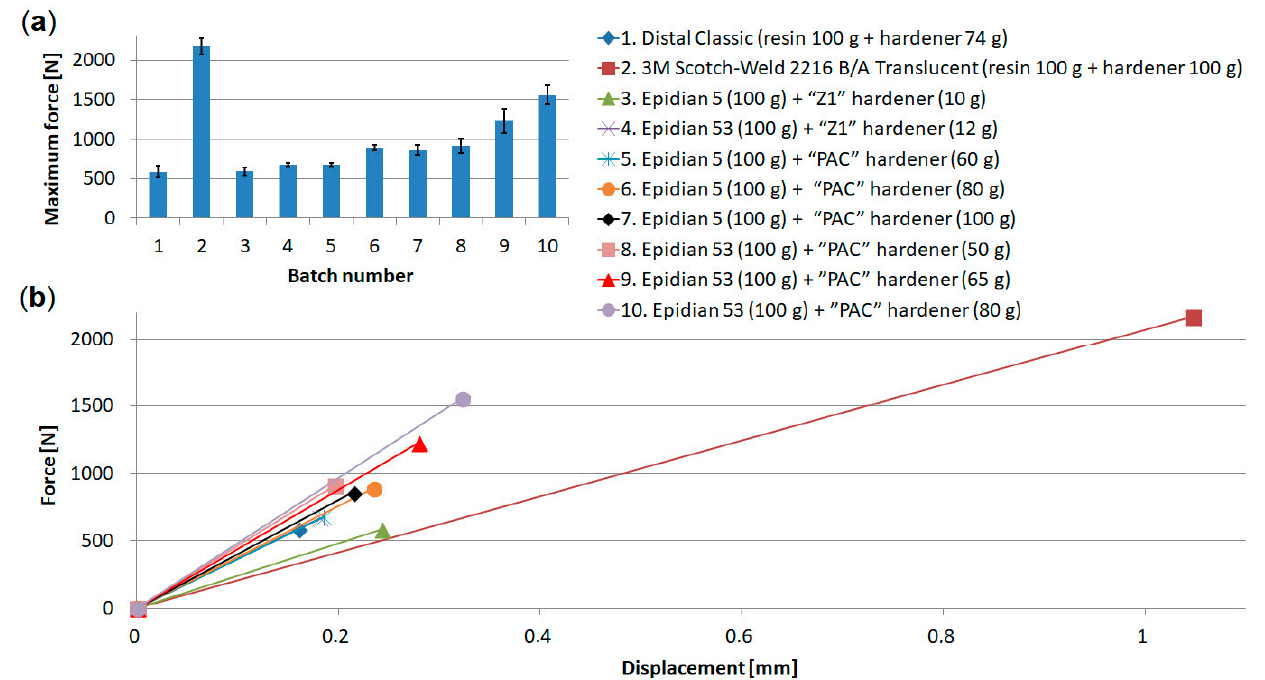
Figure 6. Summary of results of the first stage of joint operation: ( a ) summary of maximum forces, ( b ) comparison of stiffness for epoxy joints.